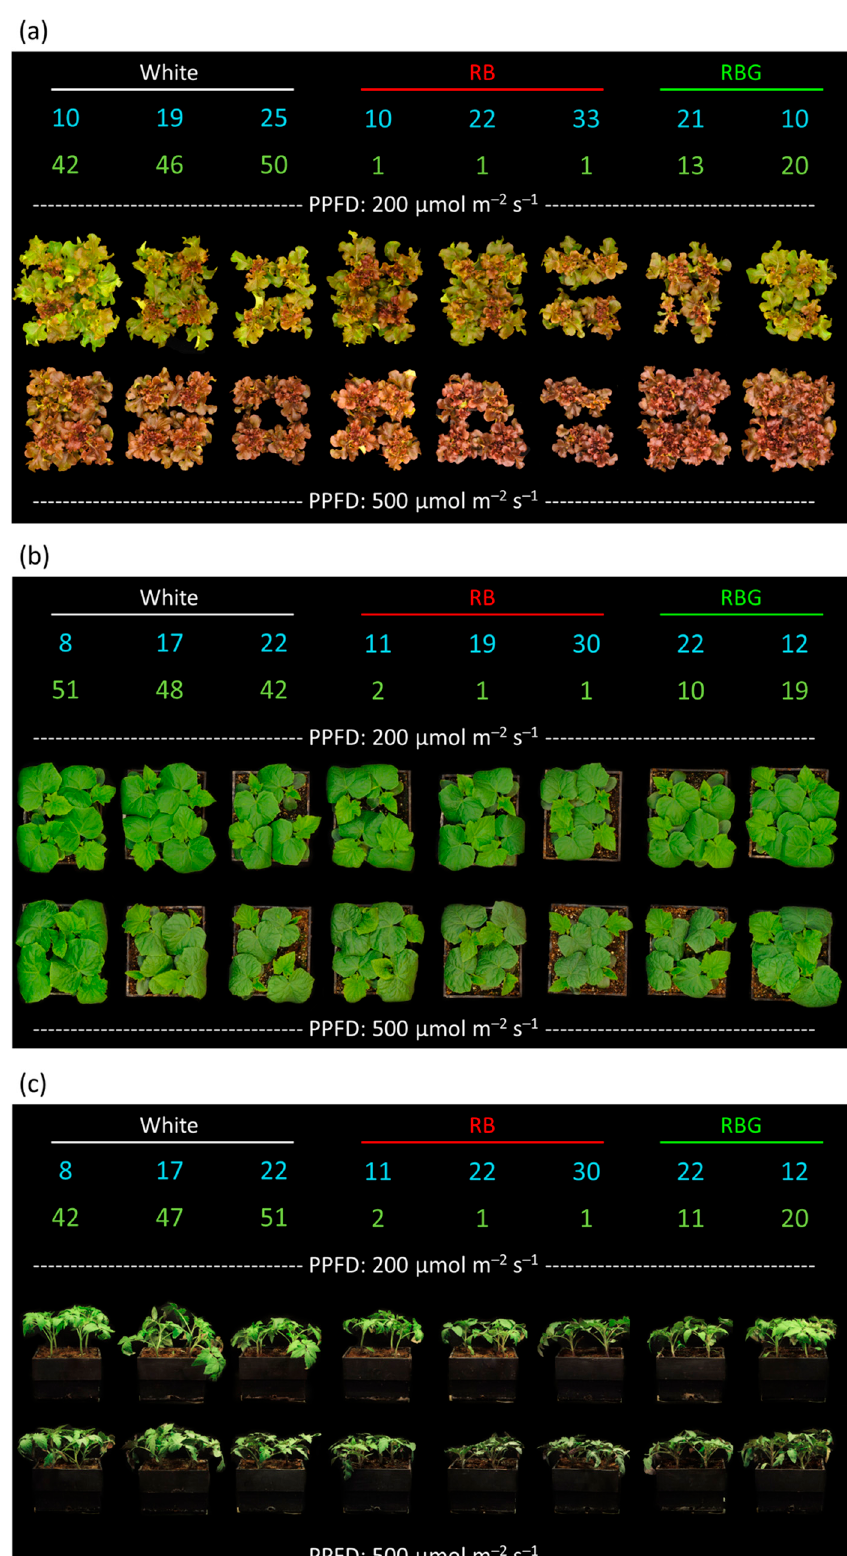
Figure 2. Representative photos from a single replicate of each treatment for ( a ) lettuce, ( b ) cucumber and ( c ) tomato. The average percentages of blue and green are shown above the plants in their respective color. RB: rad/blue; RBG: red/blue/green; PPFD: photosynthetic photon flux density.